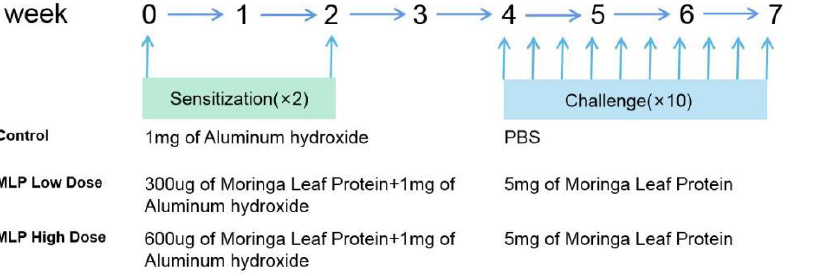
Figure 1. Mouse immunization protocol. Mice were sensitized with two intragastric administrations of MLP (MLP, 30 µ g/60 µ g per mouse) at a 14-day interval (days 0, 14) and challenged with MLP at a 2-day intervals (days 28, 30, 32, 34, 36, 38, 40, 42, 44, and 48) to establish a mouse model of food allergy in the MLP group or phosphate-buffered saline (PBS) in the controlgroup.